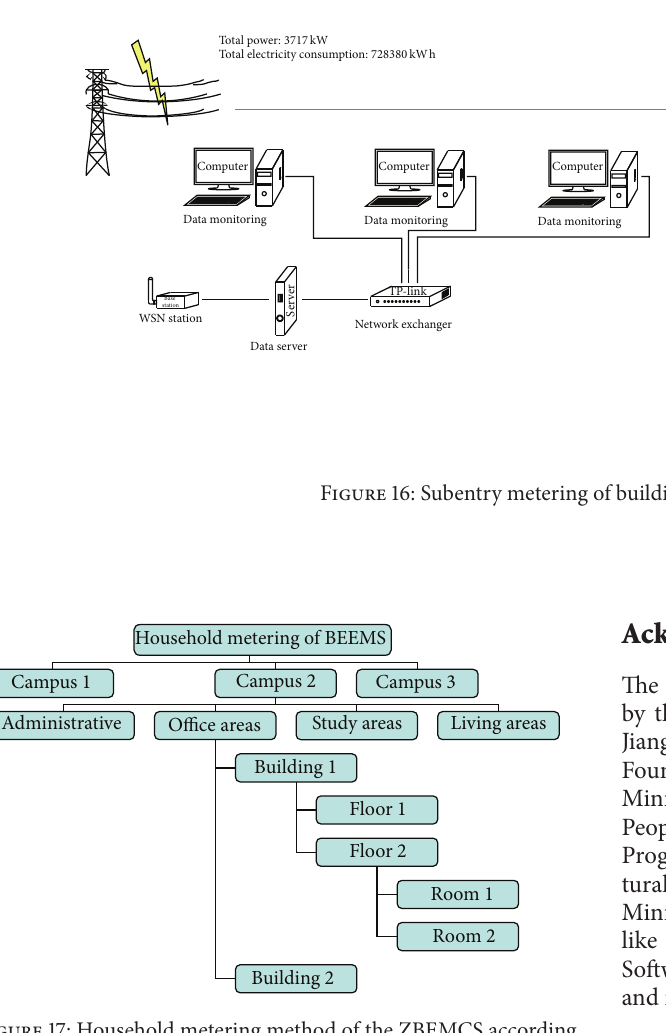
Figure 17: Household metering method of the ZBEMCS according to the campus main function.